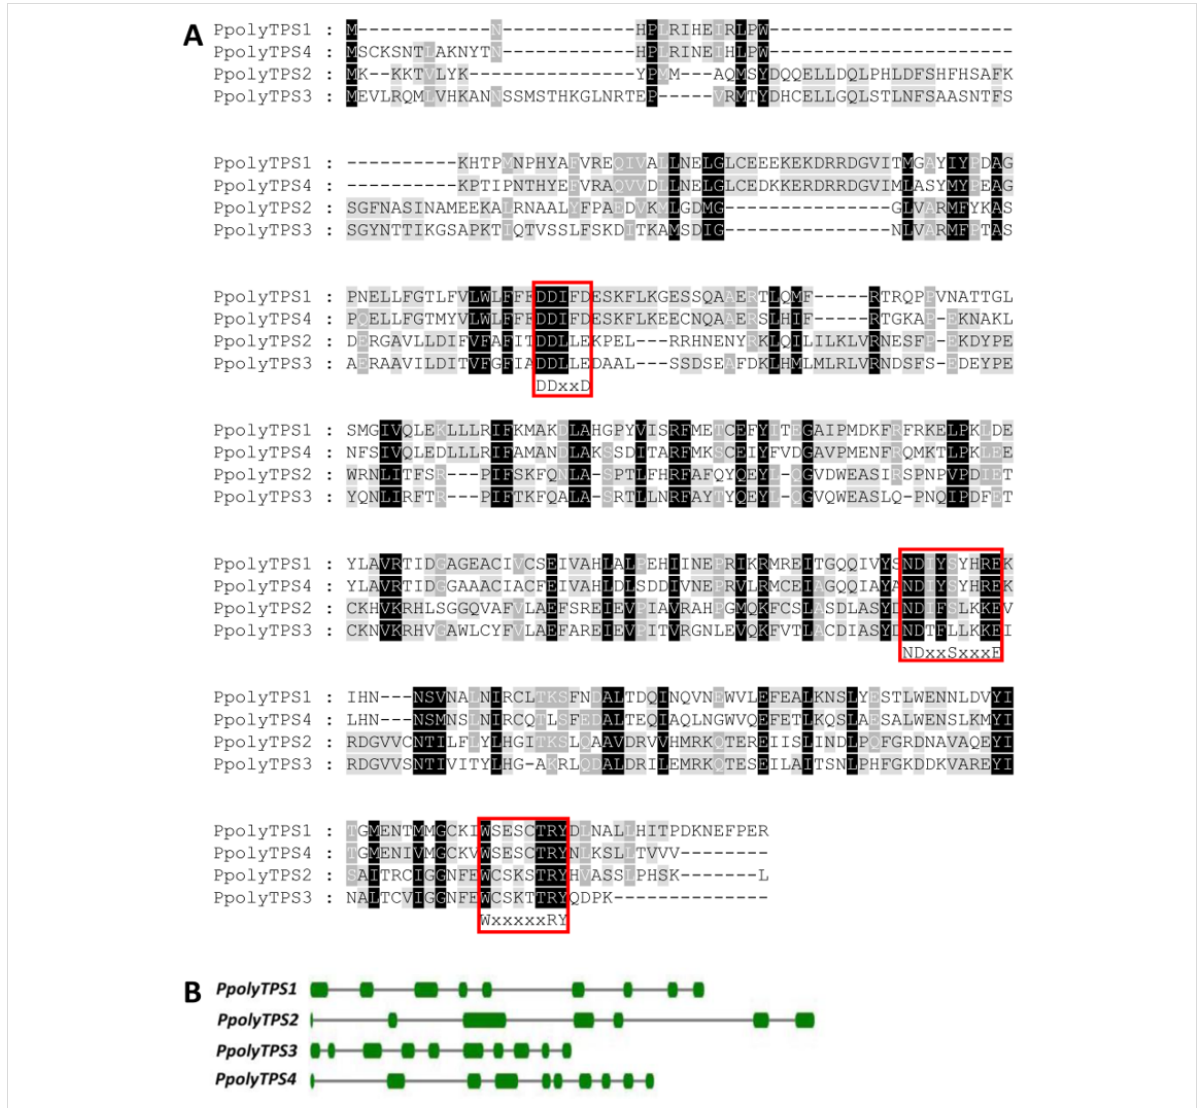
Figure 2: P. polycephalum contains four terpene synthase genes. A) Multiple sequence alignment of the protein sequences of the four PpolyTPSs. The sequences for PpolyTPS1-PpolyTPS4 reported in this paper have been deposited in the GenBank database (accession numbers. MN523652–MN523655). Three signature motifs for terpene synthases were boxed. Shadings in black and gray indicate identical and similar residues, respectively. B) Intron/exon organization of the four PpolyTPS genes. Boxes and lines indicate exons and introns, respectively.